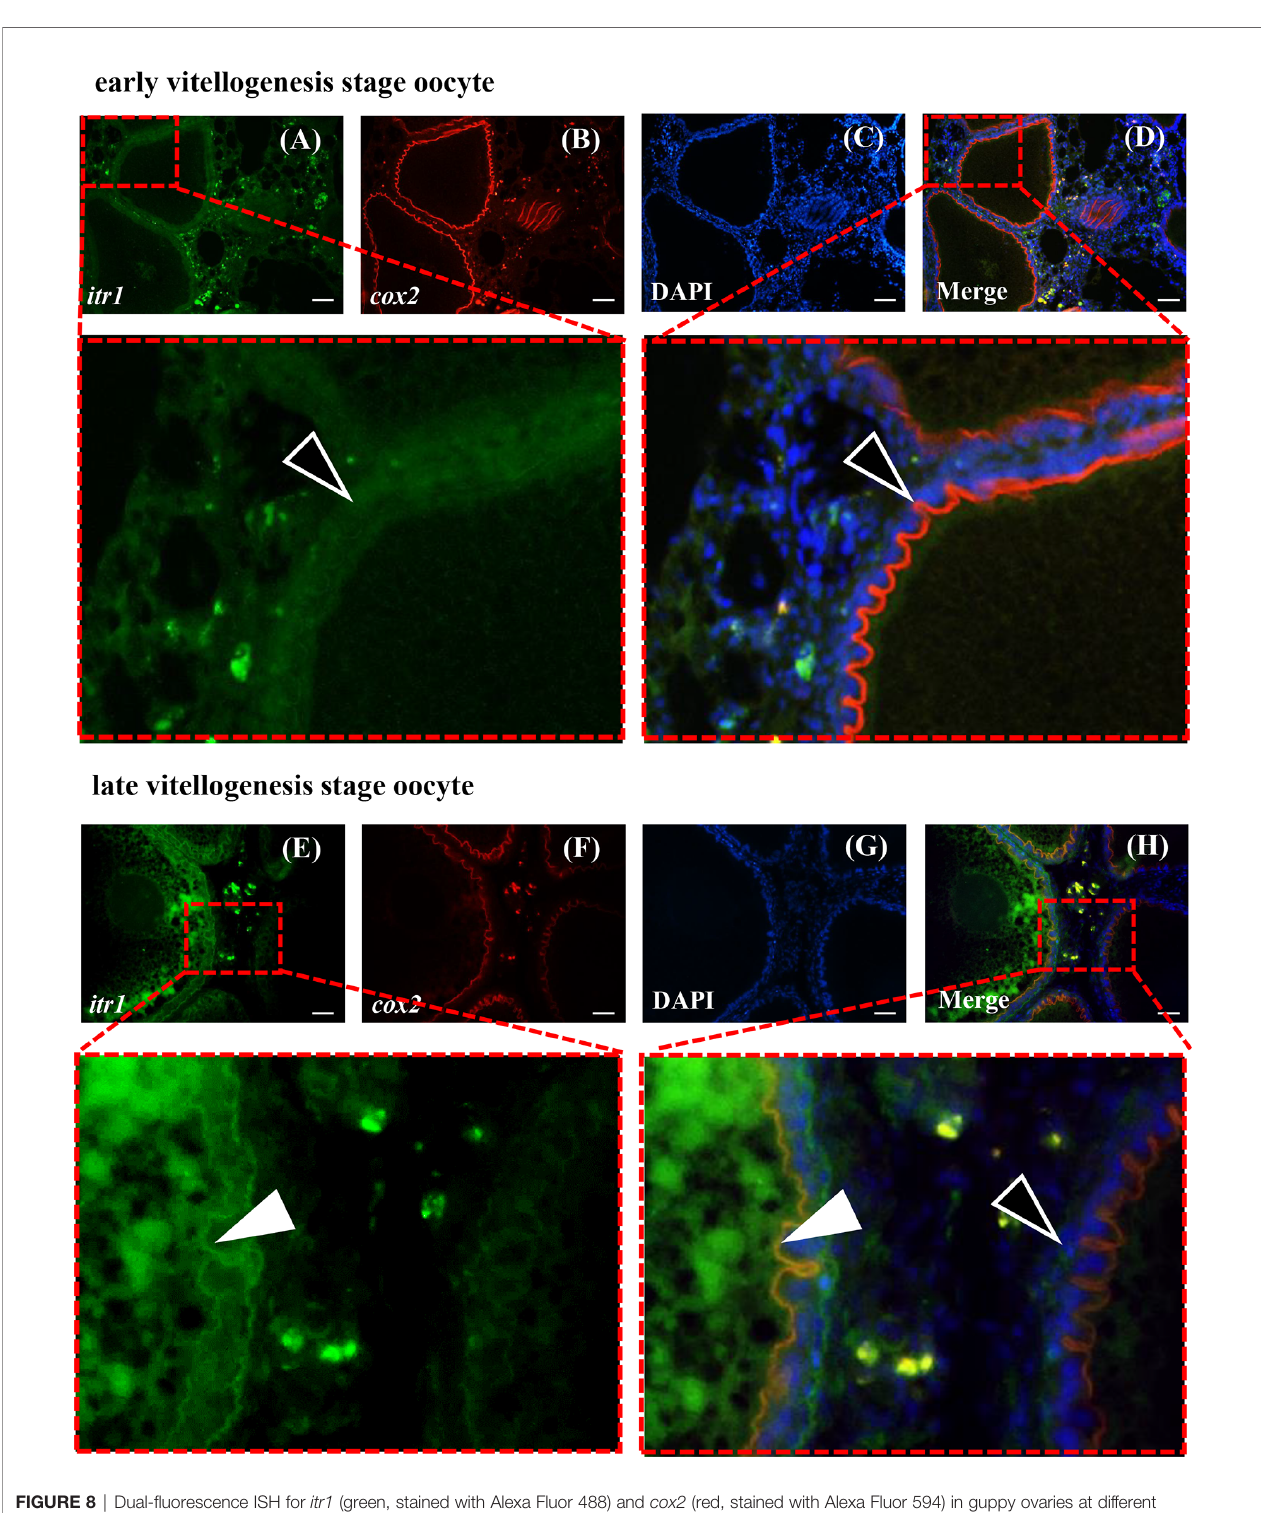
FIGURE 8 | Dual- fl uorescence ISH for itr1 (green, stained with Alexa Fluor 488) and cox2 (red, stained with Alexa Fluor 594) in guppy ovaries at different developmental stages. (A – D) ISH staining in the early vitellogenesis stage. (E – H) ISH staining in the late vitellogenesis stage. The itr1 signal overlapping with the cox2 signal in the late vitellogenesis stage in the follicular cell layer is indicated by white arrowheads. The single cox2 signal in the early vitellogenesis stage in the follicular layer is indicated by open arrowheads. Nuclei were stained with DAPI (blue). Scale bar, 20 m